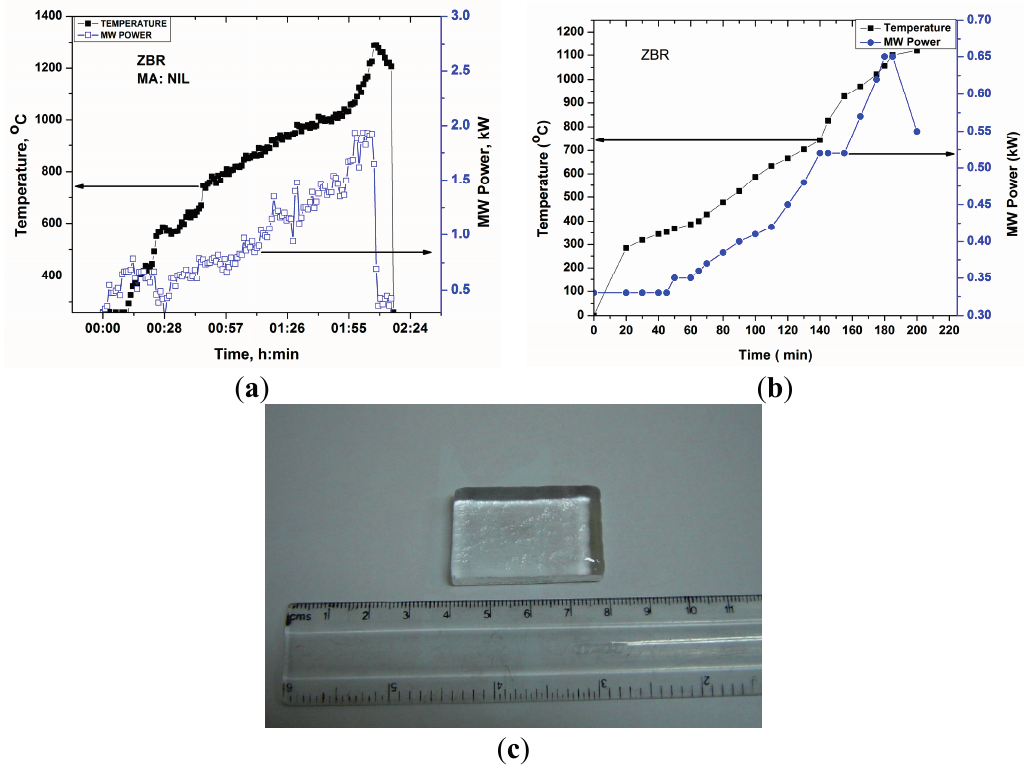
Figure 12. ( a ) T-P-t profile for zinc borate glass under direct microwave heating of powder glass batch; ( b ) T-P-t profile for zinc borate glass under microwave heating of the sintered glass batch with carbon powder around the crucible; ( c ) Photograph of annealed ZBR glass block melted by microwave